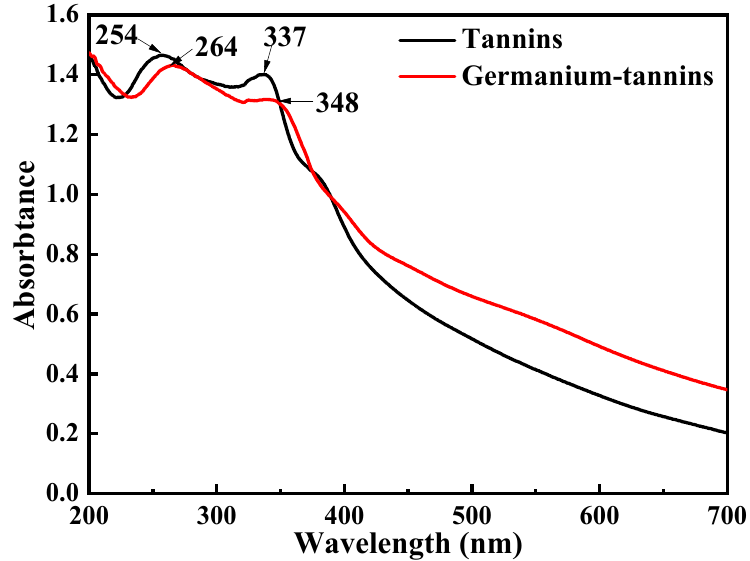
Figure 4. Tannins and germanium–tannins ultraviolet di ff use re fl ectance spectroscopy.